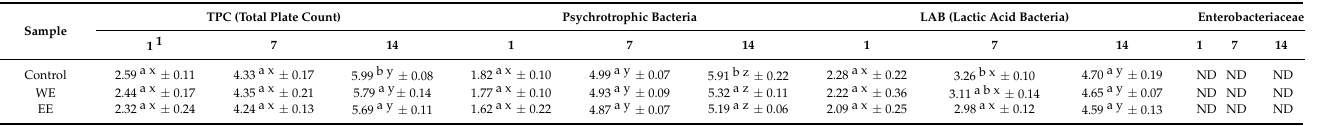
Table 5. Evolution of microbial counts of chicken meatballs during refrigerated storage. TPC(TotalPlateCount) PsychrotrophicBacteria LAB(LacticAcidBacteria) Sample